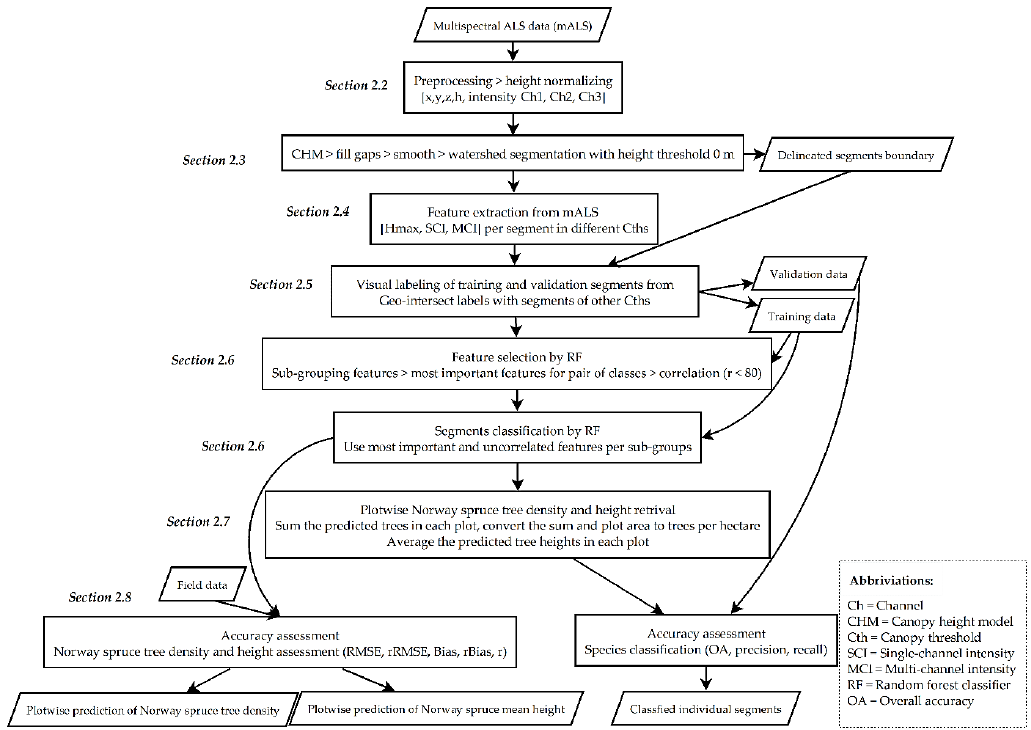
Figure 2. A flowchart outlining the methodology. Text sections are noted on the left. 191